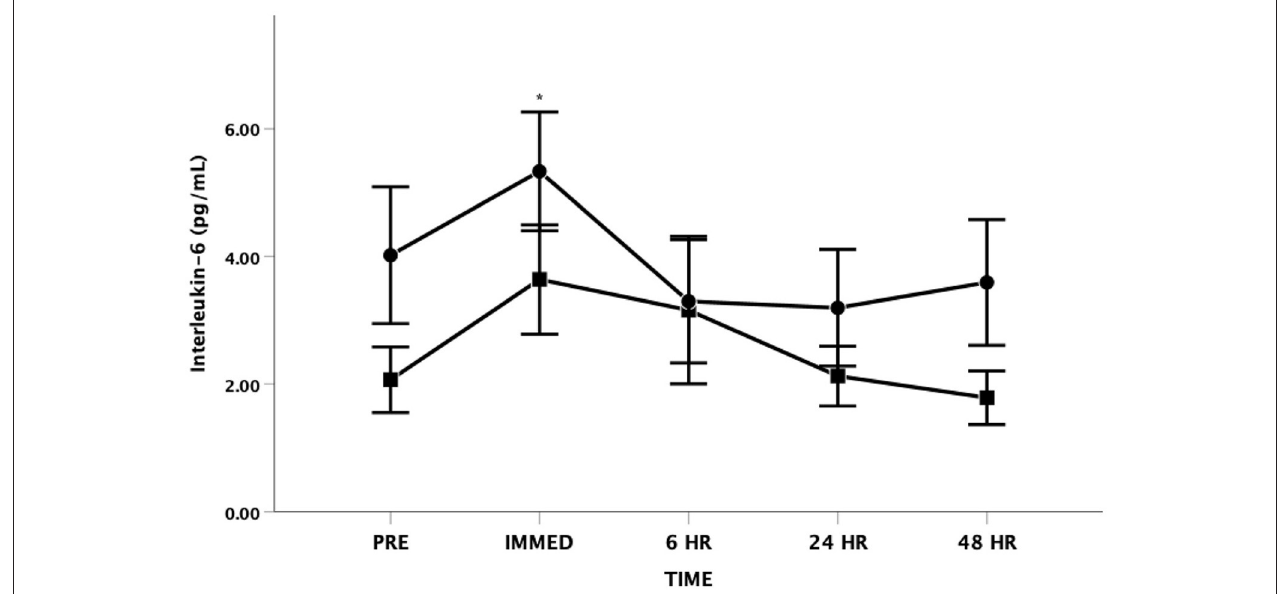
FIGURE 2 | Interleukin-6 (IL-6) as a function of time. Means ± SD. *Main effect for time observed immediately post-exercise ( p < 0.05). Circle = Steady State; Square = Interval. Error Bars = ± SEM.